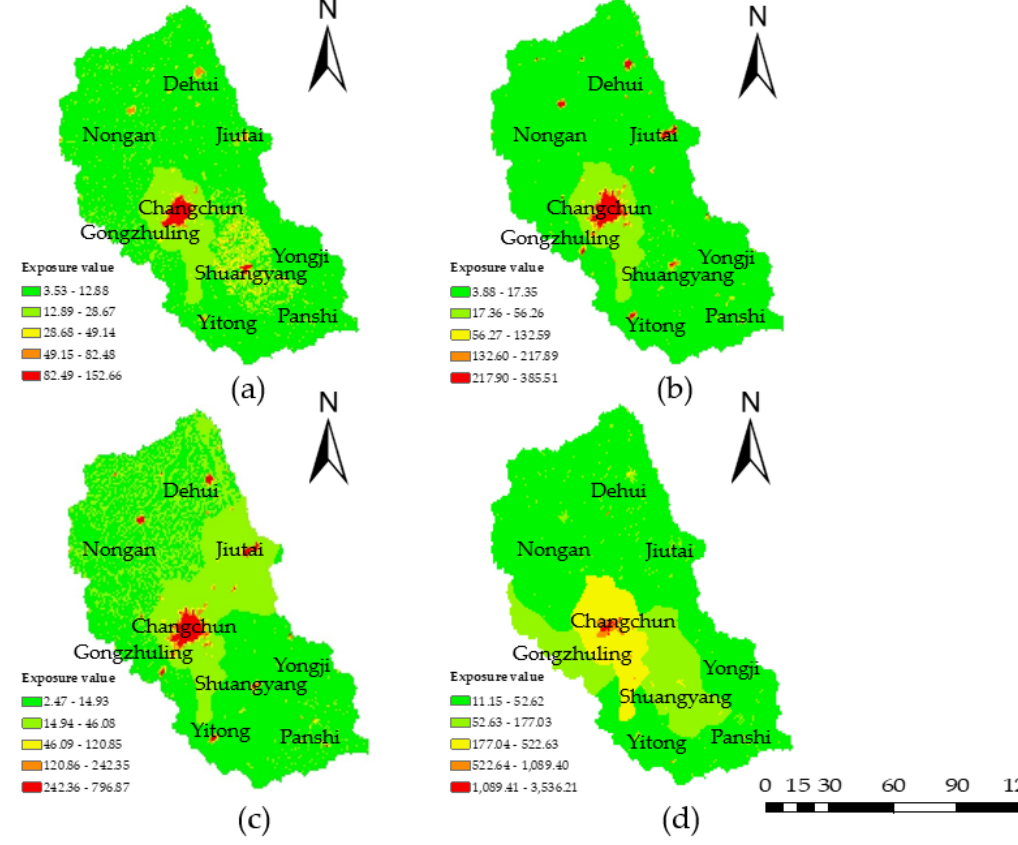
Figure 4. Water environmental exposure maps for ( a ) 2000; ( b ) 2005; ( c ) 2010; and ( d ) 2015. The color scale from green to red represents slightly exposed, lightly exposed, moderately exposed, highly exposed, and extremely exposed, respectively.